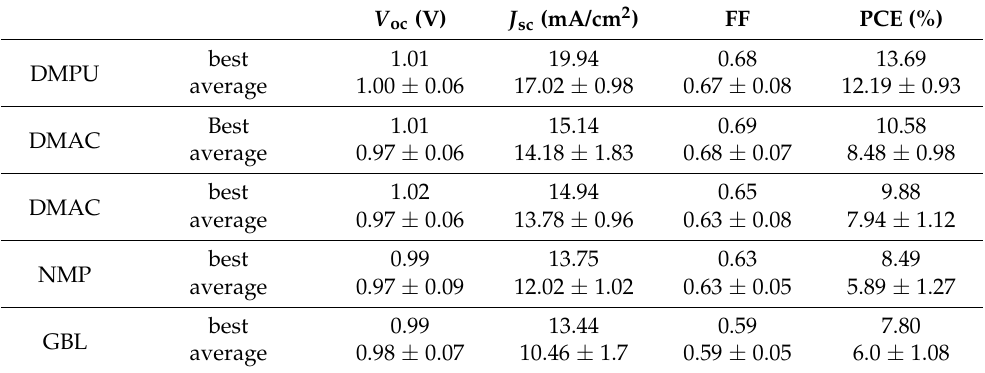
best GBL average 0.98 ± 0.07 6.0 ± 1.08 There are 30 devices taken into account to calculate the average parameters of